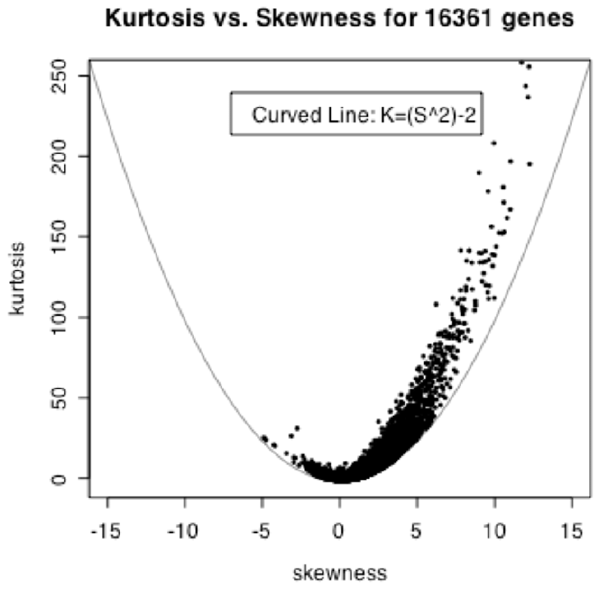
Figure 2. Kurtosis (K) vs.Skewness (S) plot for the GEPs of 16,361 features in 2,145 mouse arrays. Curved line is for the boundary curve with the equation of K=S 2 2 2.